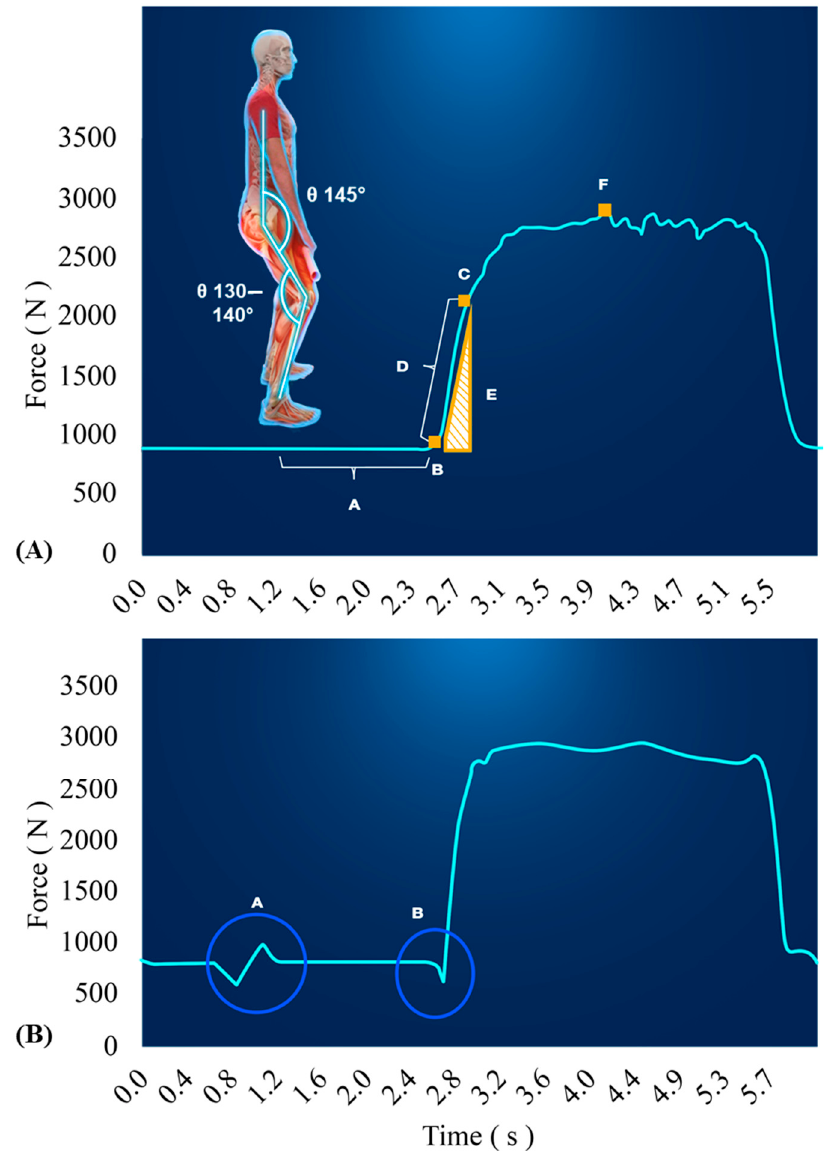
Figure 5. A correct example of a force-time curve from an isometric mid-thigh pull (IMTP) is presented in ( A ) including a one second weighing phase (point A). Example variables of interest may exist in time epochs from 0 (initiation of movement, (point B) to 250 milliseconds (point C), such as the slope of the force-time curve (point D) or the area under the force-time curve, known as impulse (point E). Additionally, peak force (point F) is calculated and often most reliable. In ( B) , common errors in assessing the IMTP are presented, such as too much movement during the weighting phase (point A) and a countermovement prior to pulling on the bar (point B).